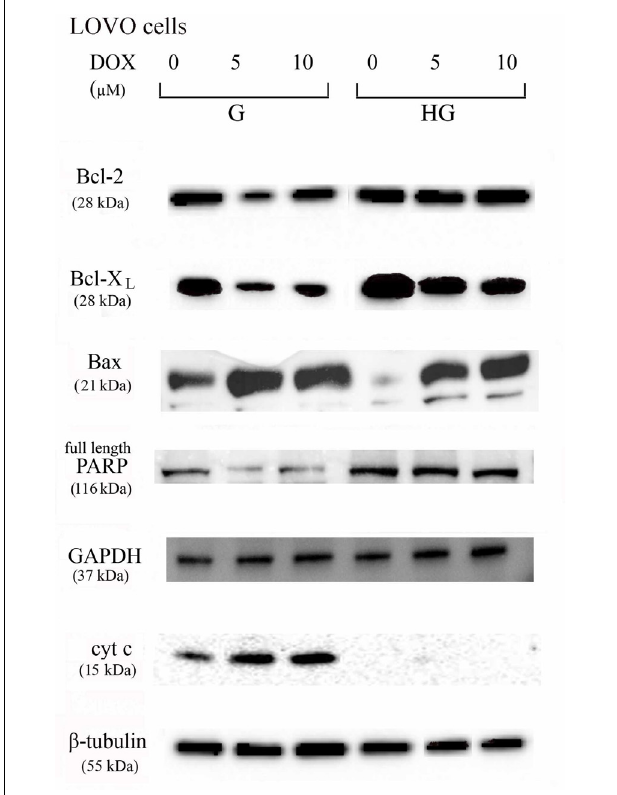
FIGURE 10 | Effect of normal glucose (G) and high glucose (HG) on Bcl-2, Bcl-XL, Bax, PARP and cyt c protein expression in absence or presence of DOX in human colon cancer LOVO cells. Cells were cultured for ≥ 7 days in the presence of G and HG, incubated for 24 h before analysis with 5 and 10 µ M DOX, then washed and lysed. The level of GAPDH, used as an housekeeping protein in total lysates, and the level of β -tubulin, used as an housekeeping protein in mitochondrial lysates, were used to check the equal protein loading. The figure is representative of three independent